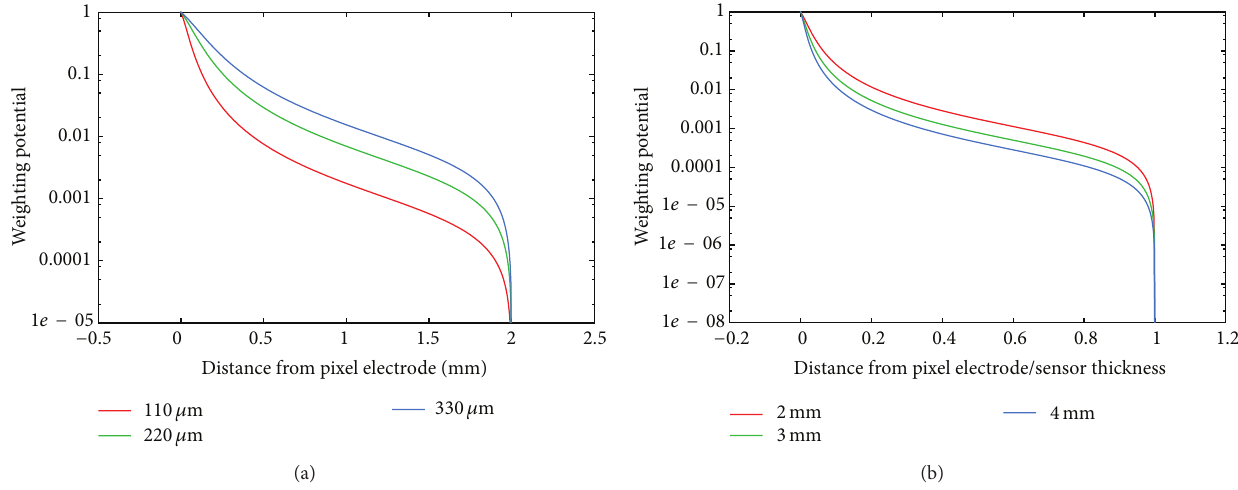
Figure 1: (a) Weighting potential for a 2mm thick CdTe sensor for different pixel pitch as functions of the distance 𝑧 from the pixel electrode plane. (b) Weighting potential for different sensor thicknesses at fixed pixel pitch of 110 𝜇 m as function of the ratio of the distance from the pixel electrode plane to the sensor thickness. Weighting potentials were calculated according to the model of Castoldi et al. [26].